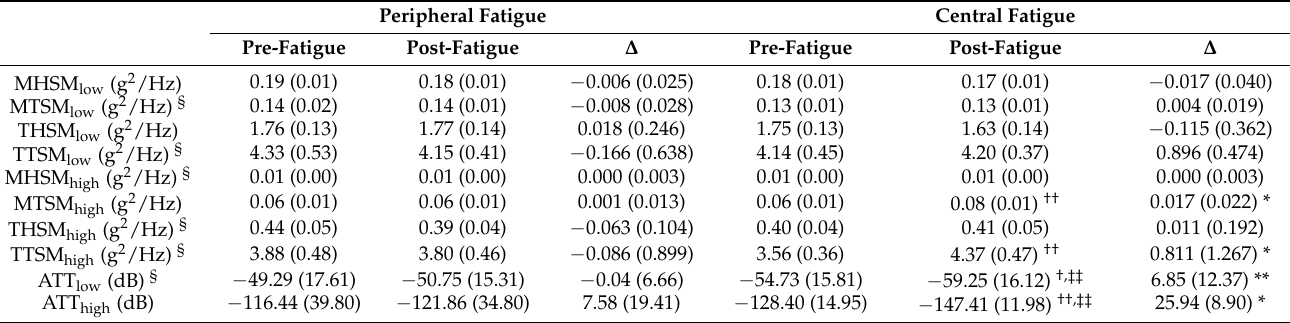
Table 3. Results (mean and standard deviation) of the impacts in the frequency-domain analysis, pre- and